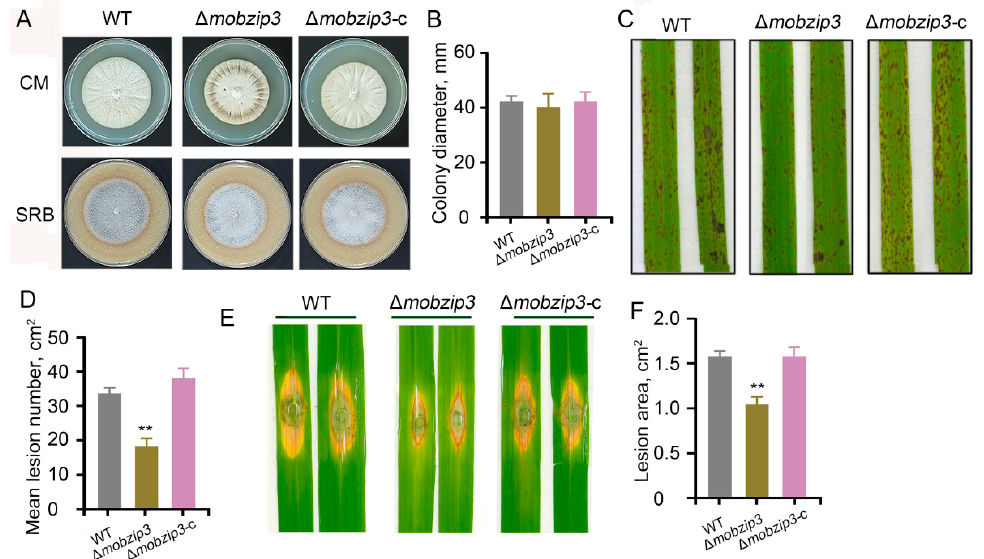
Figure 2. Pathogenesis analysis of mutants of BZIP genes. ( A ), The same numbers of conidia of WT, ∆ mobzip3 and the complemented strain ( ∆ mobzip3 -c) were cultured on the completed mediate (CM) and straw rice bran (SRB) medium. Images showing seven-day-old cultures of the indicated M. oryzae on the two types of mediums. ( B ), Colony diameter of the indicated M. oryzae in ( A ). ( C ), Pathogenesis analysis of these indicated M. oryzae using conidia spraying ( C ) or punched ( E ) inoculated methods to infect rice leaves ( O. sativa cv. Nipponbare). Images were obtained from 5 days after inoculation. The experiments were repeated three times with similar results. ( D , F ), Quantification of the lesion numbers ( C ) and area ( E ) of the rice leaves shown in ( C ) and ( E ), respectively. Error bars represent SD ( n = 20) and asterisks (**) represent a significant difference ( p < 0.01).